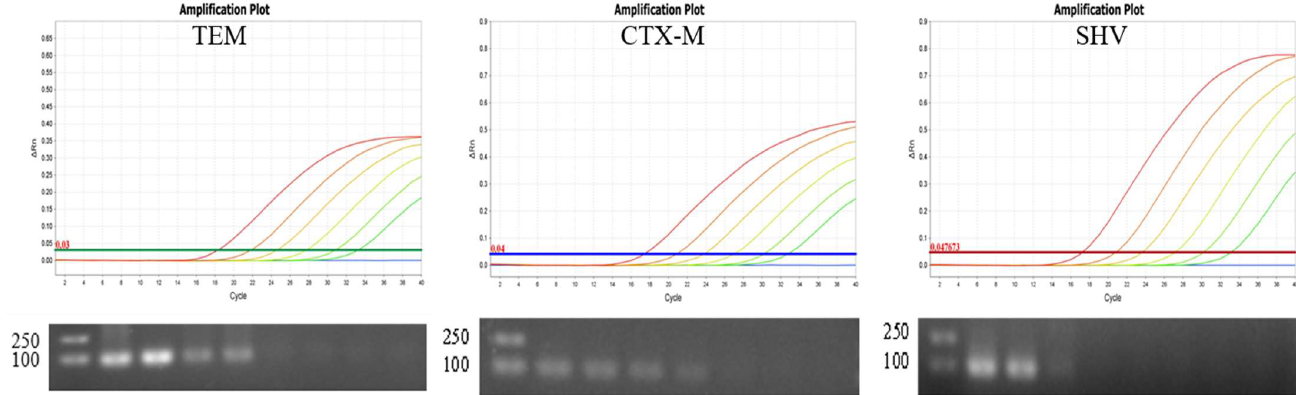
Figure 5. Sensitivity of multiple qPCR assay and PCR for bla TEM , bla CTX-M , and bla SHV genes.